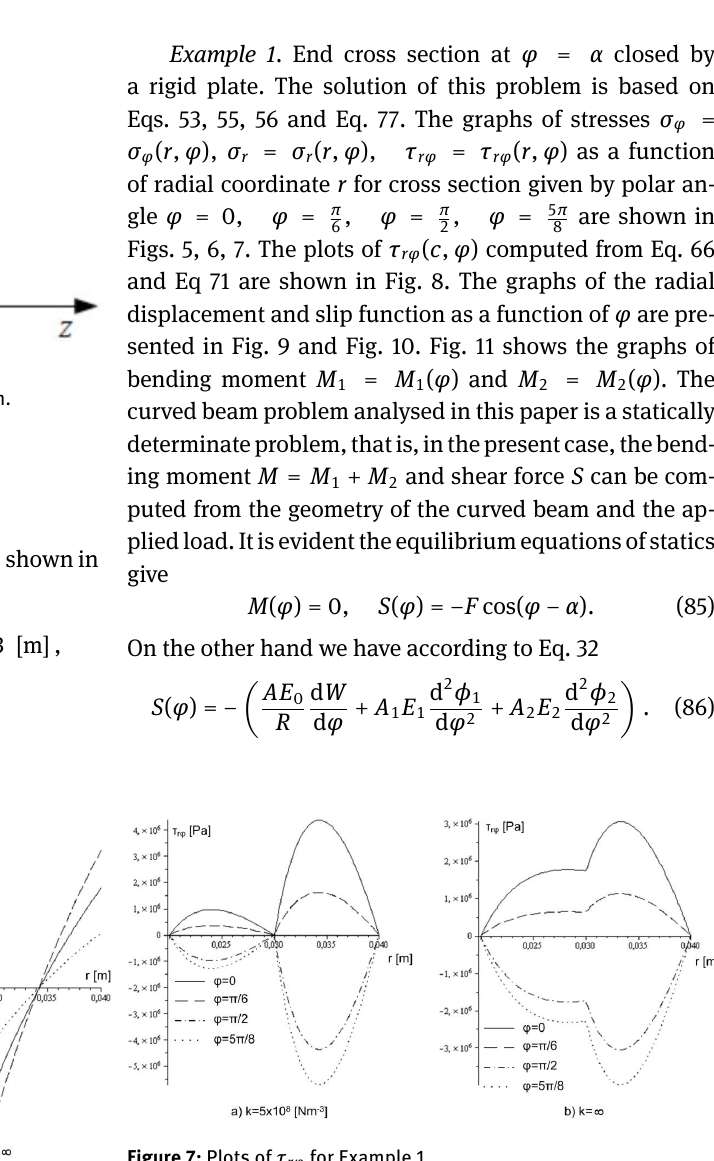
Figure 6: Plots of σ r for Example 1.